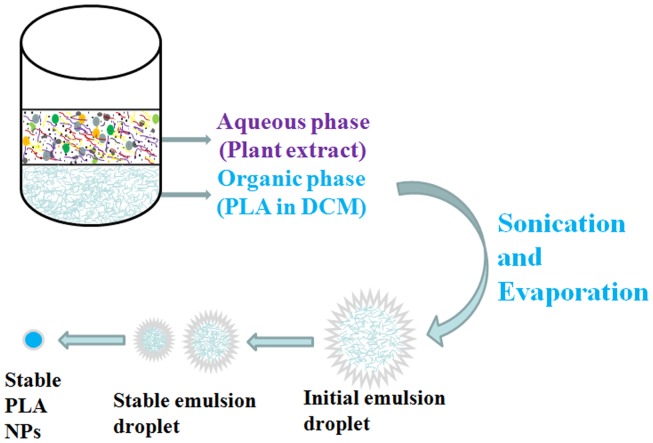
Schematic representation of fabrication of stable PLA NPs by using PEs as stabilizers/emulsifiers.